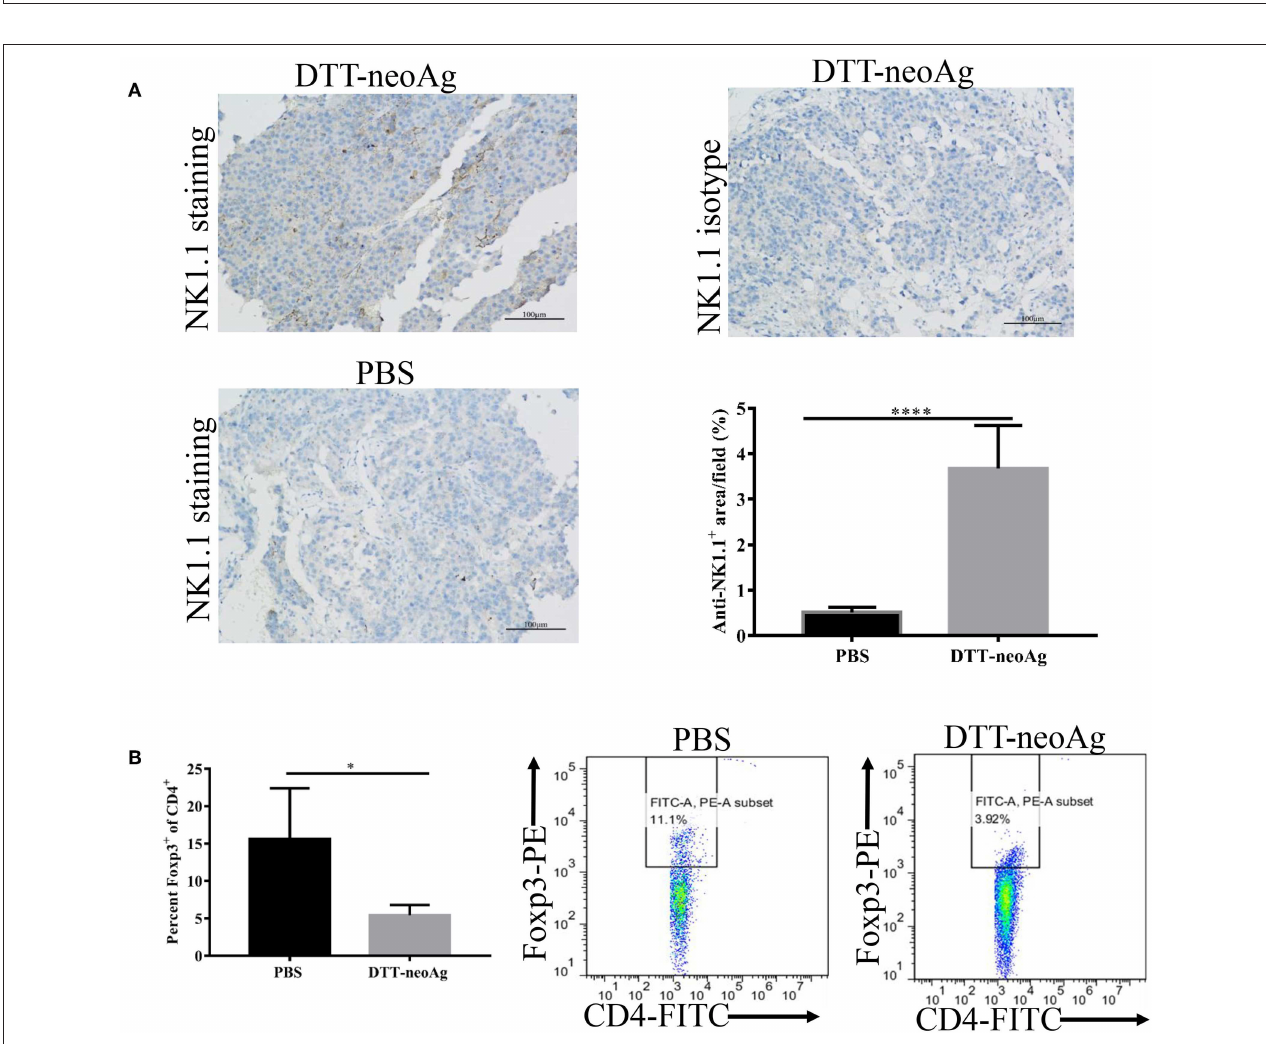
FIGURE 7 | DTT-neoAg vaccination enhances NK1.1 + cell infiltration and reduces Foxp3 + /CD4 + ratio in TILs and spleens. The statistical significances were determined by Student’s T-test. **** P < 0.0001; *** P < 0.001; ** P < 0.01; * P < 0.05. (A) B16F10 tumors from indicated mice ( n = 3) were collected and sectioned when the tumor volumes reached 1,500 mm 3 . The tissues sections were stained with anti-NK1.1 antibody. The density of NK1.1 + cells were quantified by Image J. Numbers in the panel indicate average values of three samples per group, quantified by Image J. (B) The splenocytes from DTT-neoAg or PBS vaccinated mice were isolated and stained with anti-CD3 ε -APC, anti-CD4- FITC. After permeabilization, cells were stained with anti-Foxp3-PE antibody and analyzed by flow